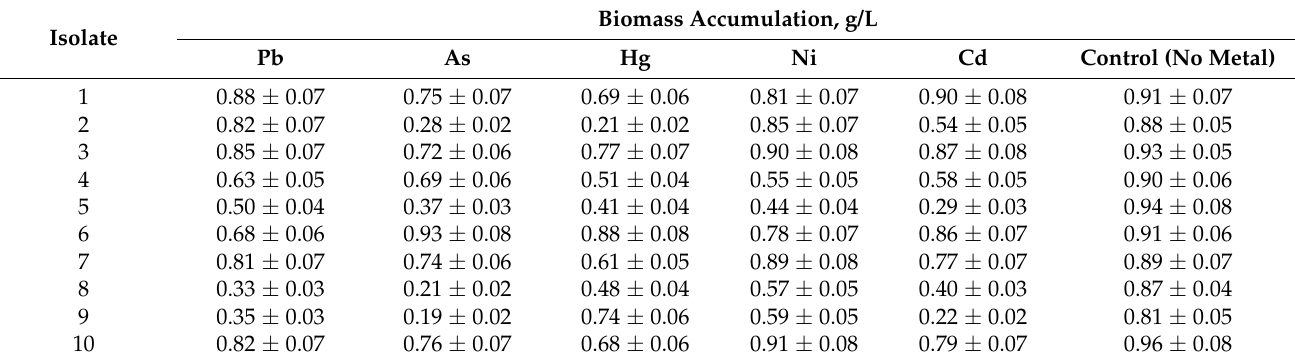
Table 3. Accumulation of biomass in an environment with individual heavy metal.